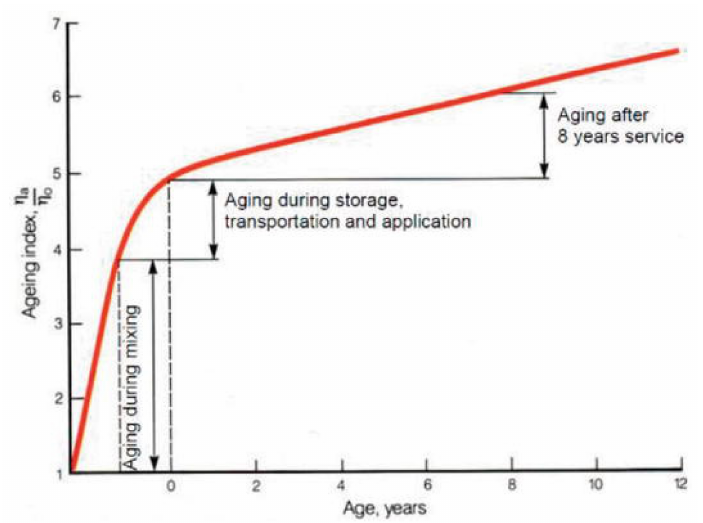
Figure 3. Aging effects on binder properties represented by the viscosity ratio index during the life of the bitumen